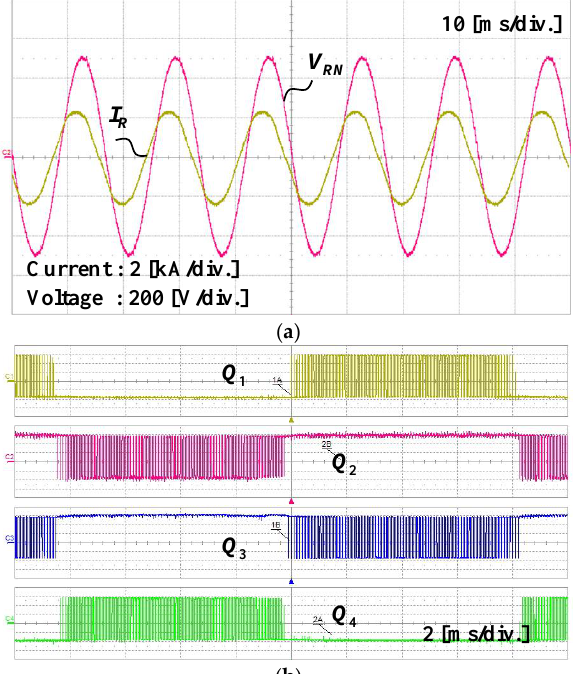
Figure 14. Experimental results in the case where the power factor is controlled at 1.0 using the proposed switching scheme: ( a ) waveforms of the output voltage and current; ( b ) waveforms of the gate signal. 10 [ms/div.]